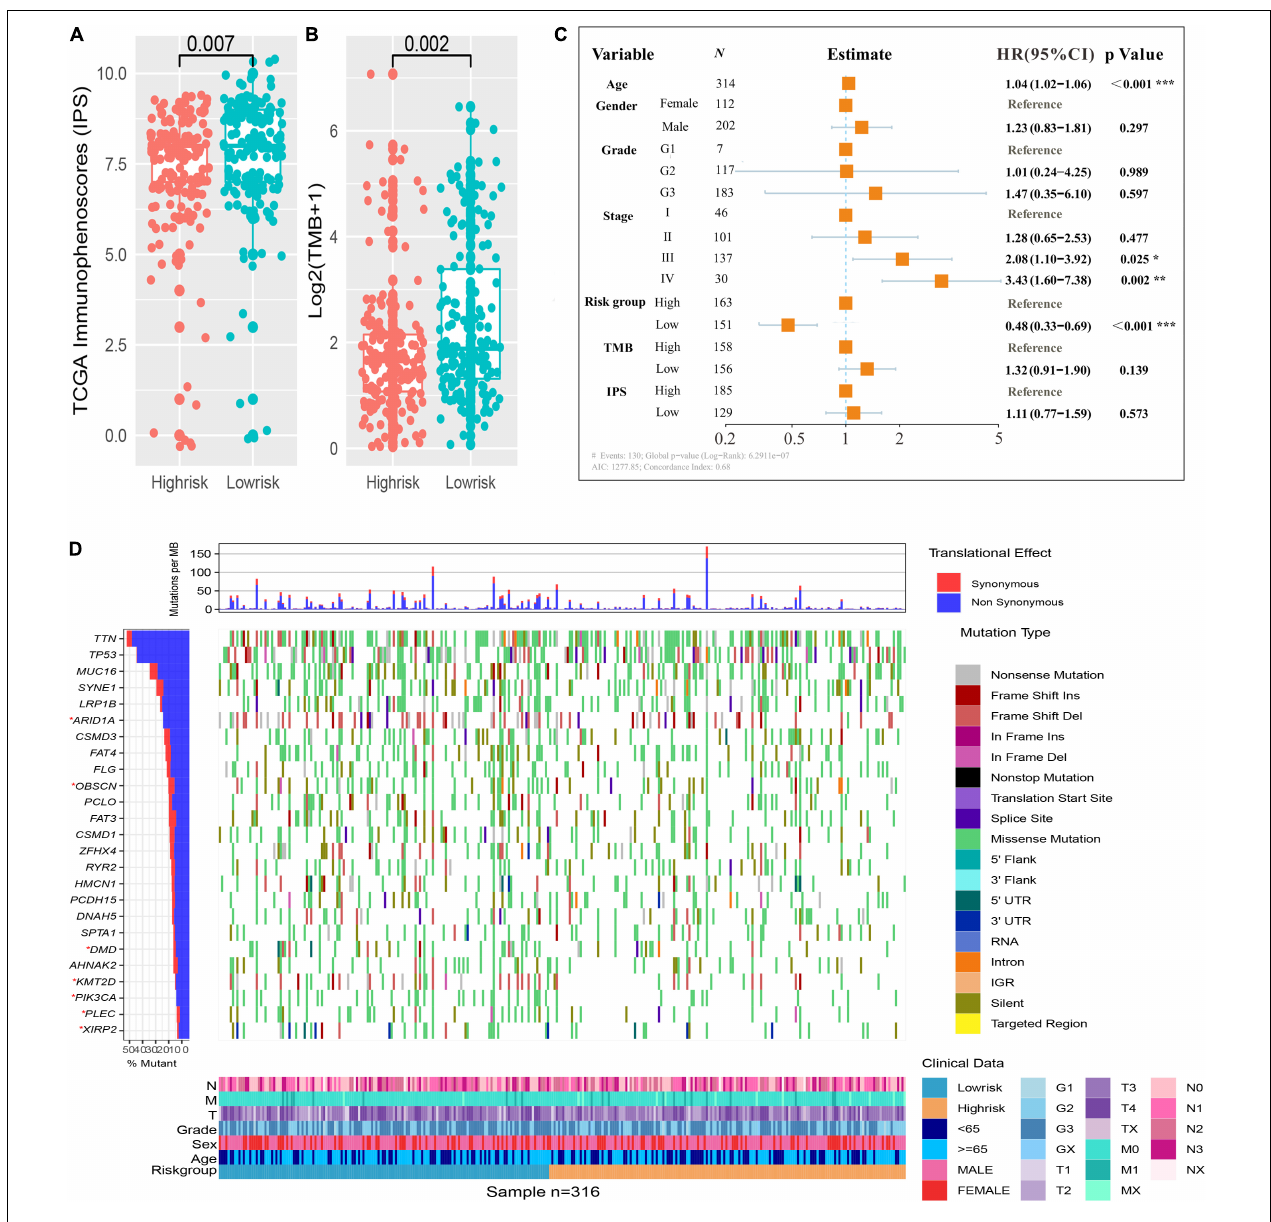
FIGURE 6 | Immune risk signature was associated with Immunophenoscore (IPS) and tumor mutation burden (TMB). Difference boxplot of IPS and TMB between high- and low-risk immune groups (A,B) . Multivariate Cox regression analysis (C) delineated the survival-related independent factors, taking into account clinical variables, signature, IPS, and TMB. Mutational landscape of SMGs (D) stratified by high- and low-risk signature groups was presented based on the somatic mutational annotation files of GC in the TCGA